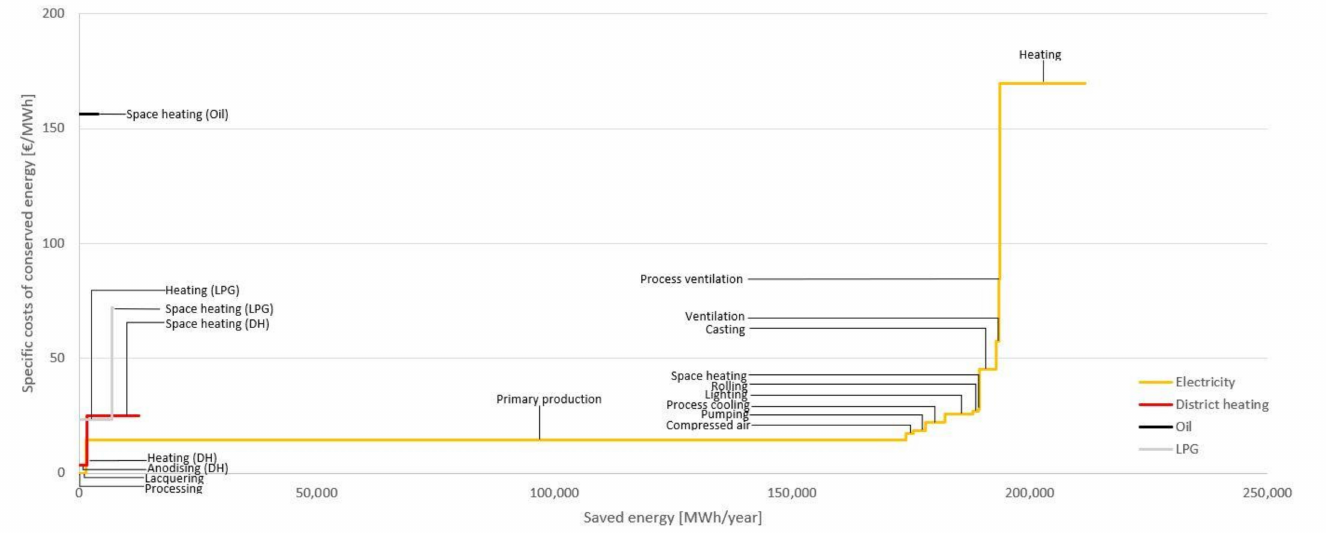
Figure 14. The energy saving potential at a process and energy carrier level for the Swedish aluminium industry and two aluminium casting